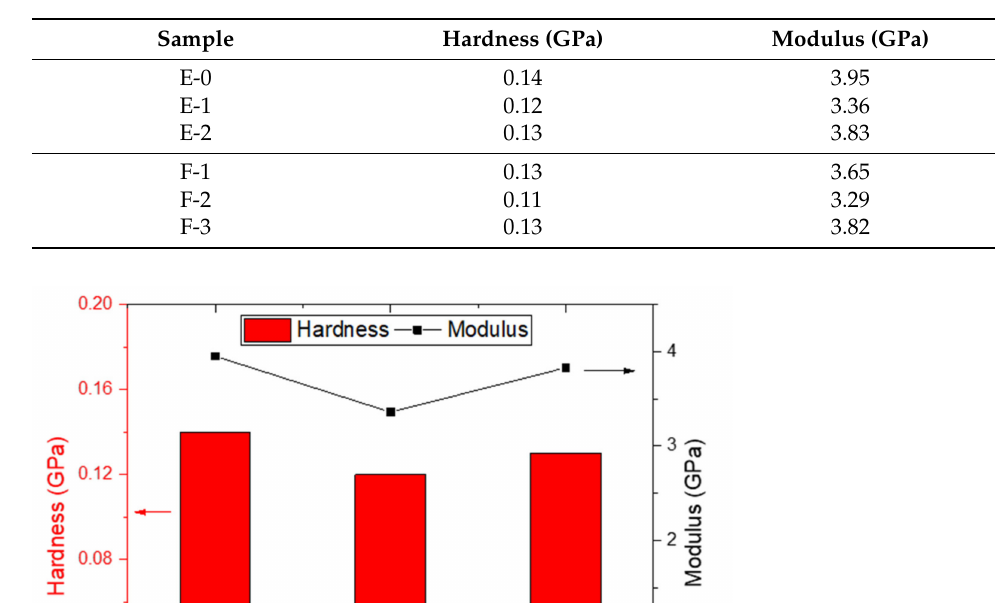
Table 4. Obtained values of Hardness and Modulus for coatings prepared with PA-450 and PA-3282 in different percentages.